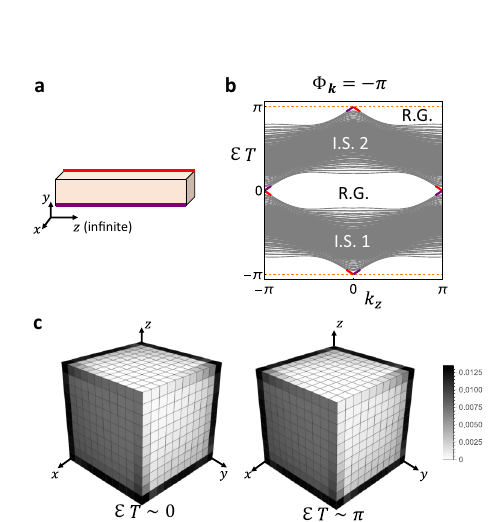
Here we only consider the DSIs for FGUs with irreducible symmetry data. P.G. means plane group, and H.B.N. means the number of Hilbert bases for each plane group. In the column for nontrivial DSI sets, None means there are no combinations of Hilbert bases that give nontrivial DSIs, and the number in the bracket is the number of Hilbert-bases combinations that give the DSI set in front of the bracket.